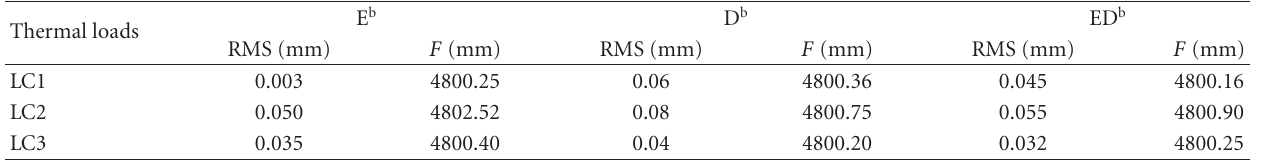
Table 2: RMS errors for thermal